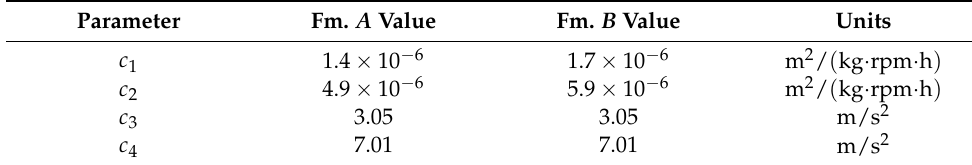
Table 2. Parameter values used in Equations (1) and